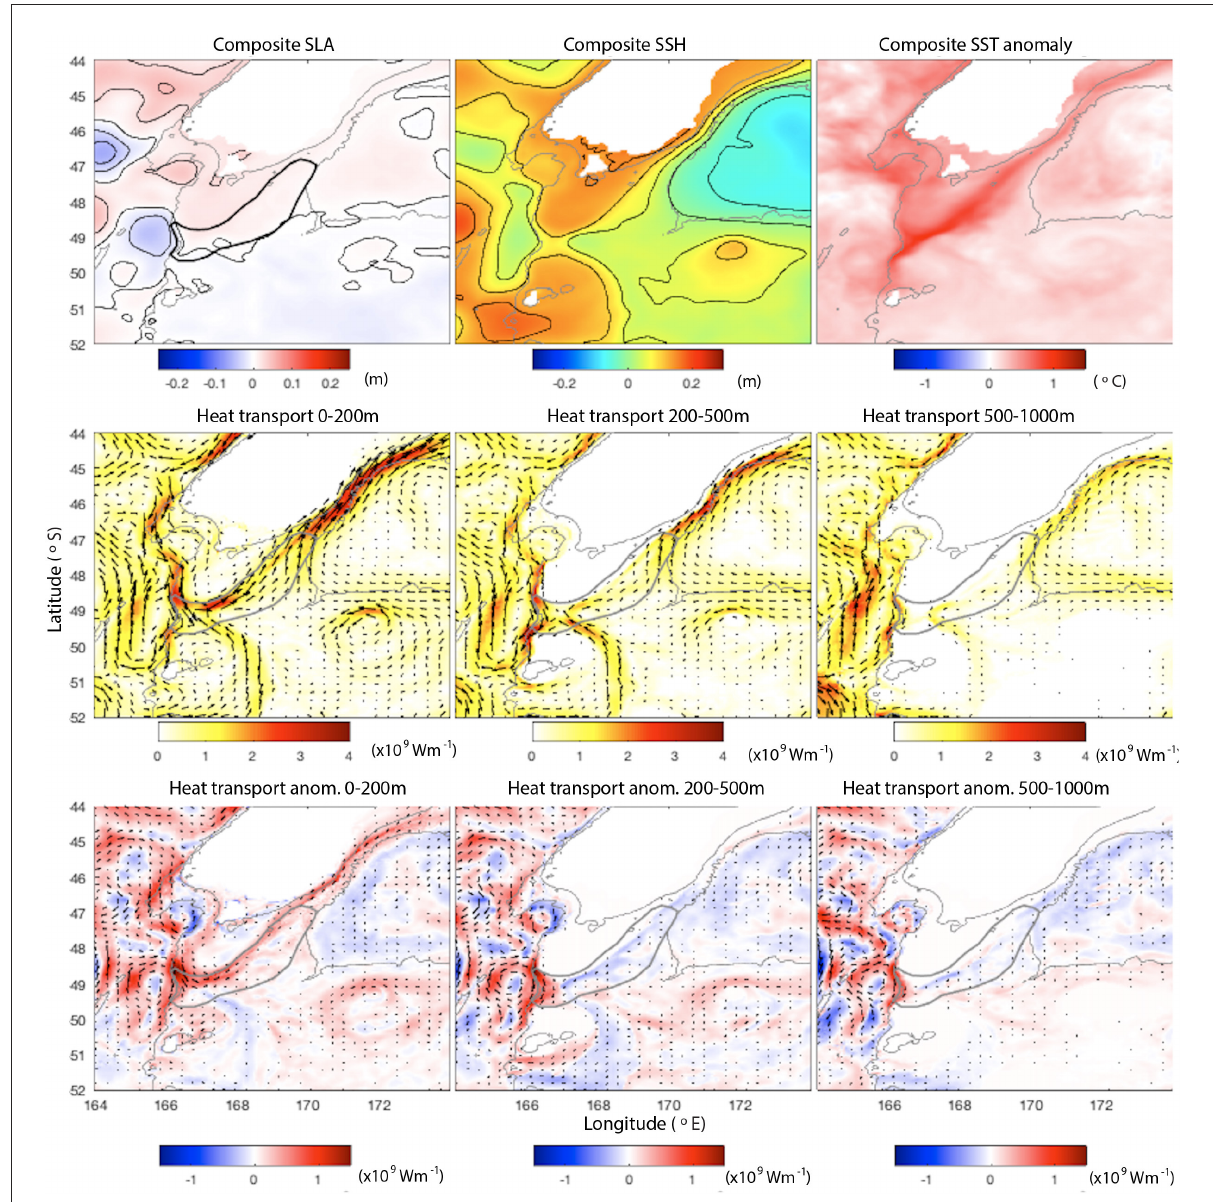
FIGURE11 (Top) : Ensemble means of SSH anomaly, SSH and SST anomaly averaged over the 4 days leading up to all 52 MHW events in the Stewart Plateau and Snares Shelf region. (Middle) : Ensemble means of depth-integrated heat transport averaged over the 4 days leading up to MHW events from 0 to 200, 200 to 500, and 500 to 1,000 m (Wm − 1 ). (Bottom) : Ensemble means of depth-integrated heat transport anomalies (Wm − 1 ). Gray lines show the 100 and 1,000 m bathymetry